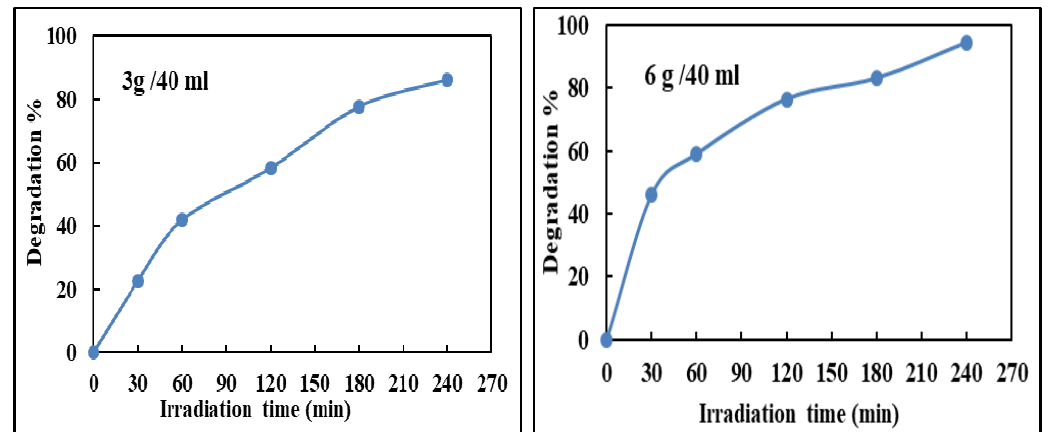
Figure 8: Degradation percentage of MB(5ppm) by ZnO/epoxy nanocomposite (2wt.%) verses irradiation time under solar light